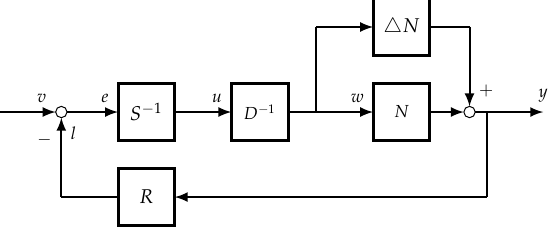
Figure 3. Nonlinear feedback system with disturbances.